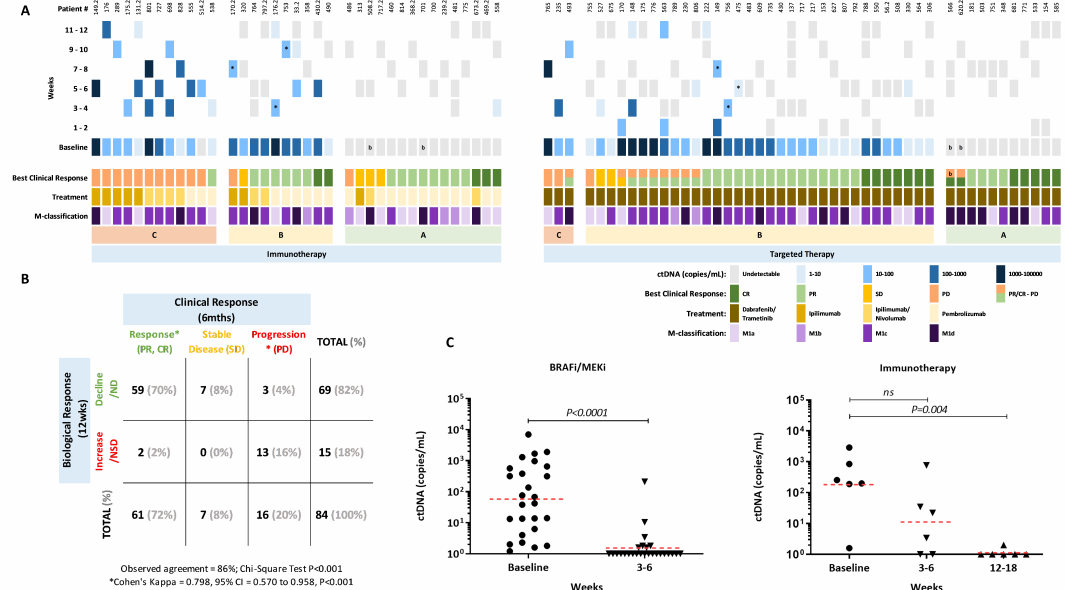
Figure 2. ctDNA levels early during treatment relative to clinical response. ( A ) Columns represent each patient, best clinical response, treatment type and longitudinal quantitative ctDNA results. Patients treated with immunotherapy or targeted therapy were stratified into three profile groups: A = undetectable ctDNA at baseline and during treatment with a biological response, B = detectable ctDNA at baseline that became undetectable during treatment or had a significant biological response and C = detectable / undetectable ctDNA at baseline that remained or became detectable during therapy without significant biological response. * Significant Biological Response. b Presence of only intracranial malignant disease at baseline or at PD. ( B ) Concordance between best clinical response at 6 months and biological ctDNA response within the 12 weeks of treatment. Patients categorised as clinically responders (PR / CR, N = 61), patients with stable disease (SD, N = 7) and patients with disease progression (PD, N = 16) and, ctDNA responders (Group A and B; N = 69) or non-responders (Group C; N = 15) based on their biological ctDNA response over the first 12 weeks of treatment. Abbreviations: ND = Not detectable; NSD = Non-significant decrease. ( C ) Plasma ctDNA levels at baseline and follow-up in patients that responded to targeted therapy (N = 26) and to immunotherapy (N = 6). P -values of paired t-tests are indicated. The geometric mean ctDNA concentration is indicated for each group by a dashed red